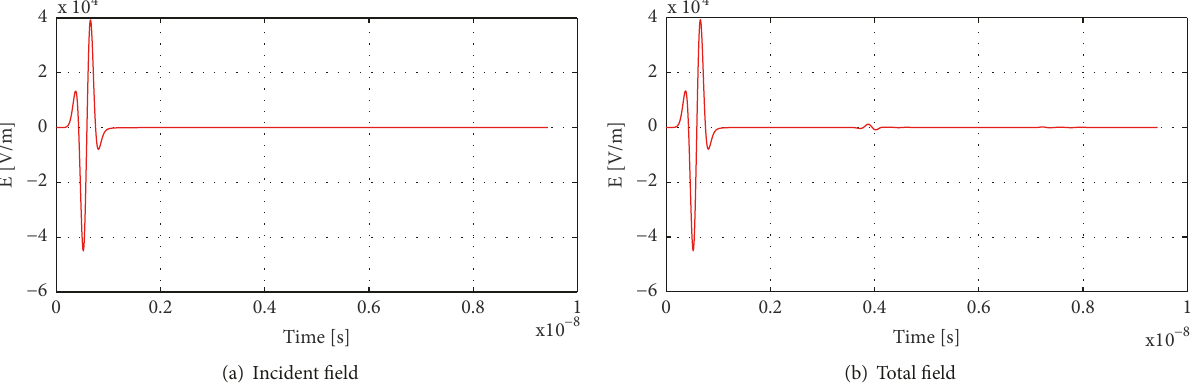
Figure 4: Electric signals generated by the first transmitter.